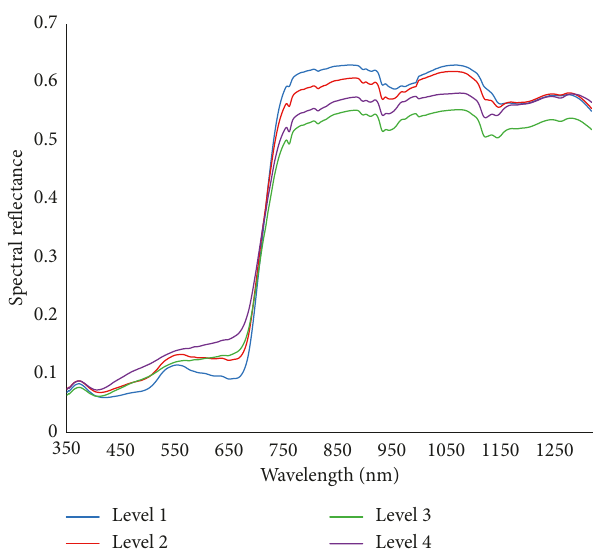
Figure 3: Spectral reflectance curves of wheat ear with different scab severity.